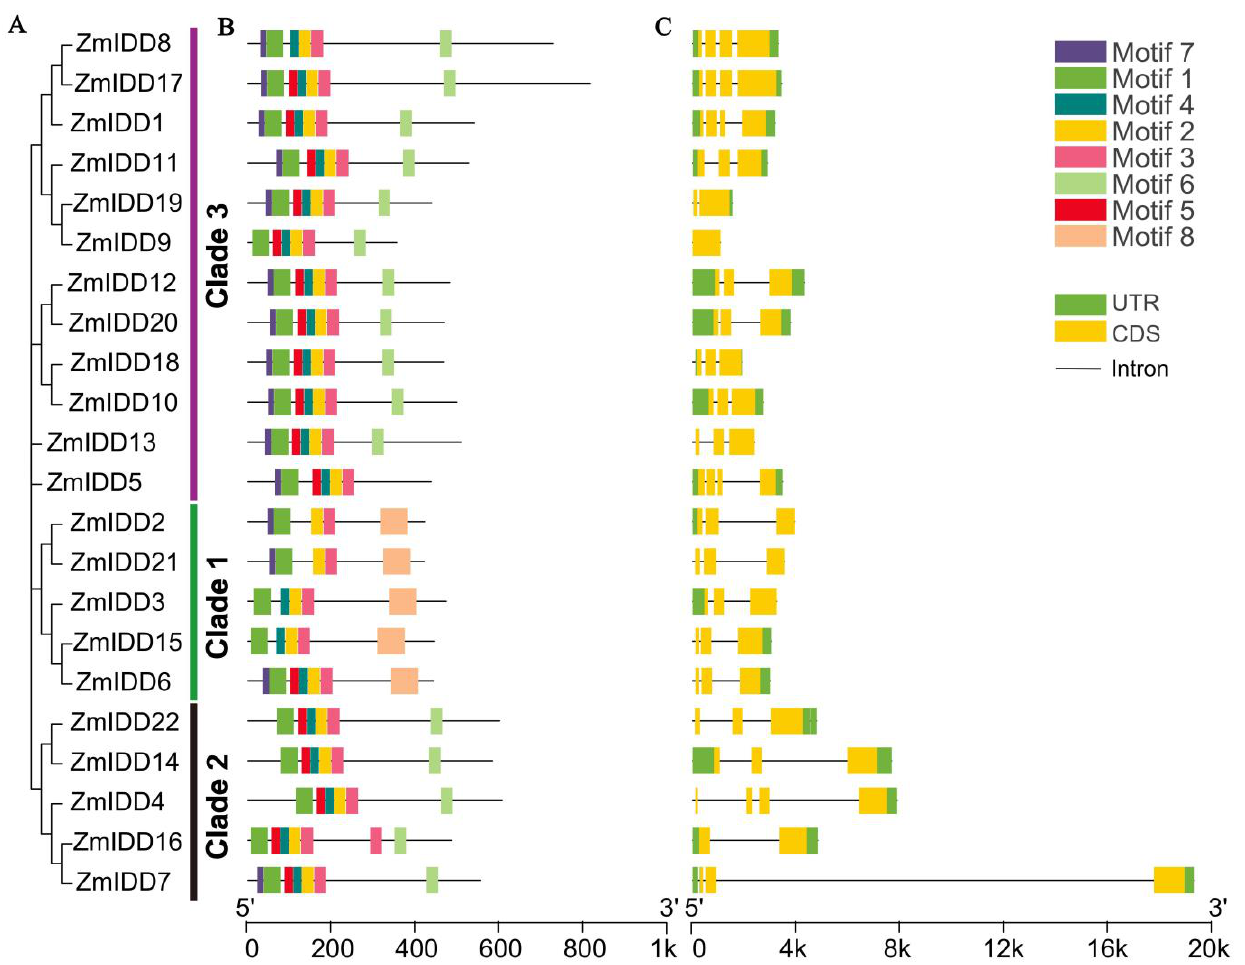
Figure 2. Phylogenetic relationships, architecture of conserved protein motifs, and gene structure in IDD genes from maize. ( A ) The phylogenetic tree was constructed based on the full-length sequences of maize IDD proteins using MEGA version 7.0 software. ( B ) The motif compositions of 22 ZmIDD proteins. The motifs were identified using the MEME program. Boxes of different colors represent motifs 1 to 10. The length of the amino acid sequences can be estimated by the scale at the bottom . ( C ) Gene structures of 22 ZmIDD genes. Yellow boxes represent exons, green boxes represent 5′ or 3′ untranslated regions (UTR), and black lines represent introns. The length of nucleotide sequences of exons/introns/UTRs can be estimated by the scale at the bottom .